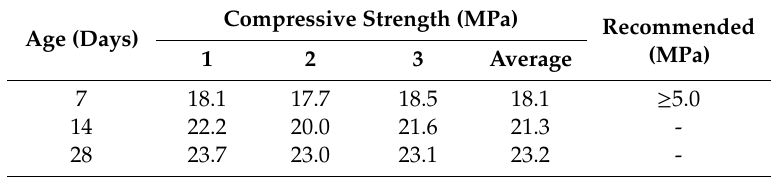
Table 6. Compressive strength test